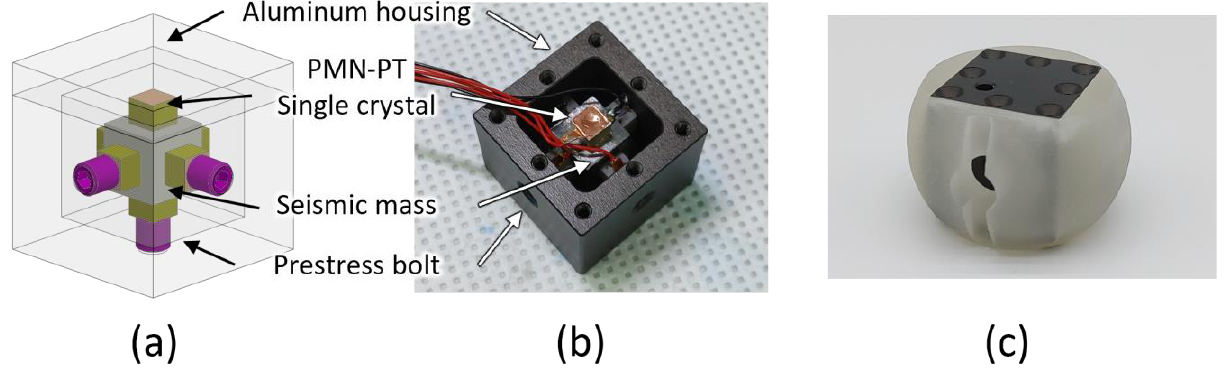
Figure 3. ( a ) Schematic view of the three-dimensional (3D) accelerometer. ( b ) Photograph of the accelerometer without the lid. ( c ) Photograph of the assembled 3D accelerometer in its 3D printed housing.